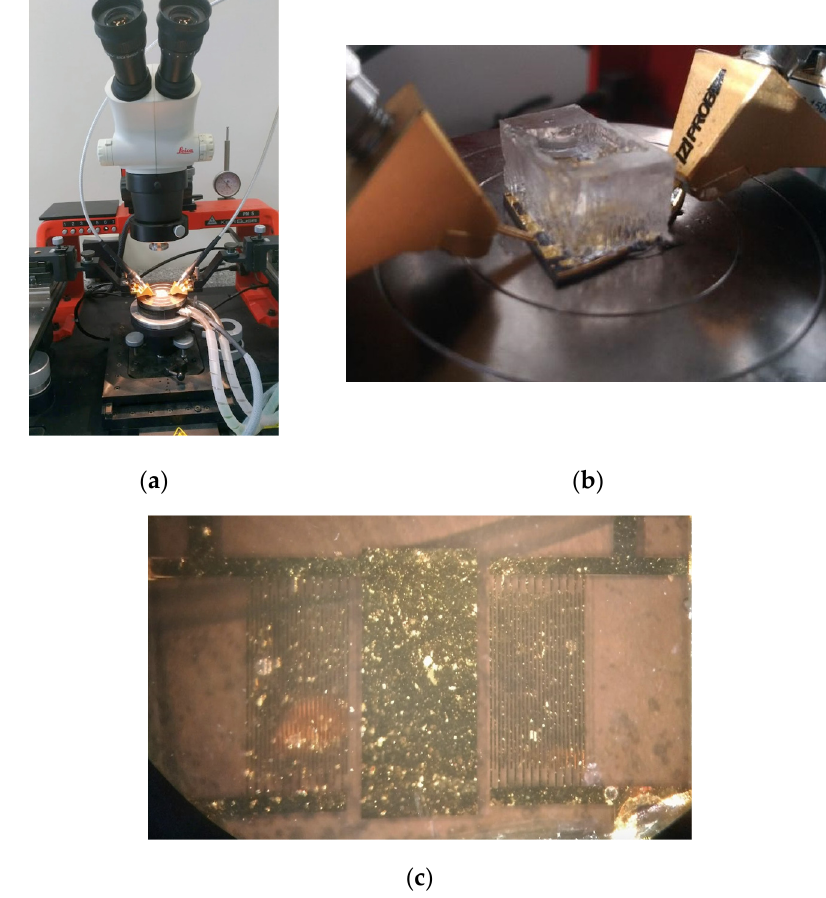
Figure 7. ( a ) The characterization system consisted of the probe station PM5 SÜSS MicroTec